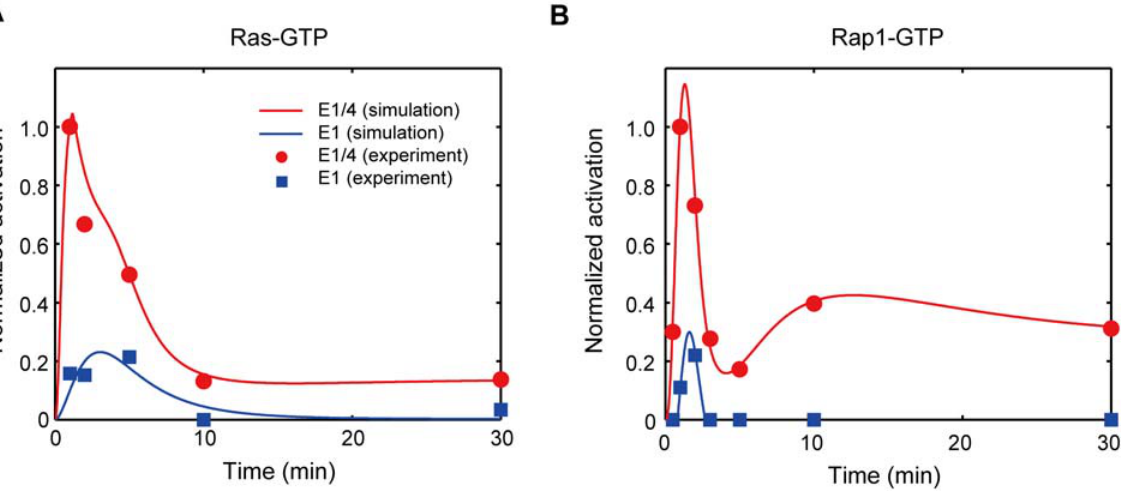
Figure 4. Time courses of Ras- and Rap1-GTPs. The input signal generator reproduced the time-course data of Ras- and Rap1-GTPs with 10 nM EGF. (A) Normalized time-course data of Ras-GTP. (B) Normalized time-course data of Rap1-GTP. The graphs represent the normalized activity of Ras- and Rap-1 GTPs in which the data are divided by the value for E1/4 cells at 1 min. Blue and red lines correspond to simulation data for E1 and E1/4 cells, respectively. The filled squares and circles correspond to experimental data concerning E1 and E1/4 cells, respectively.